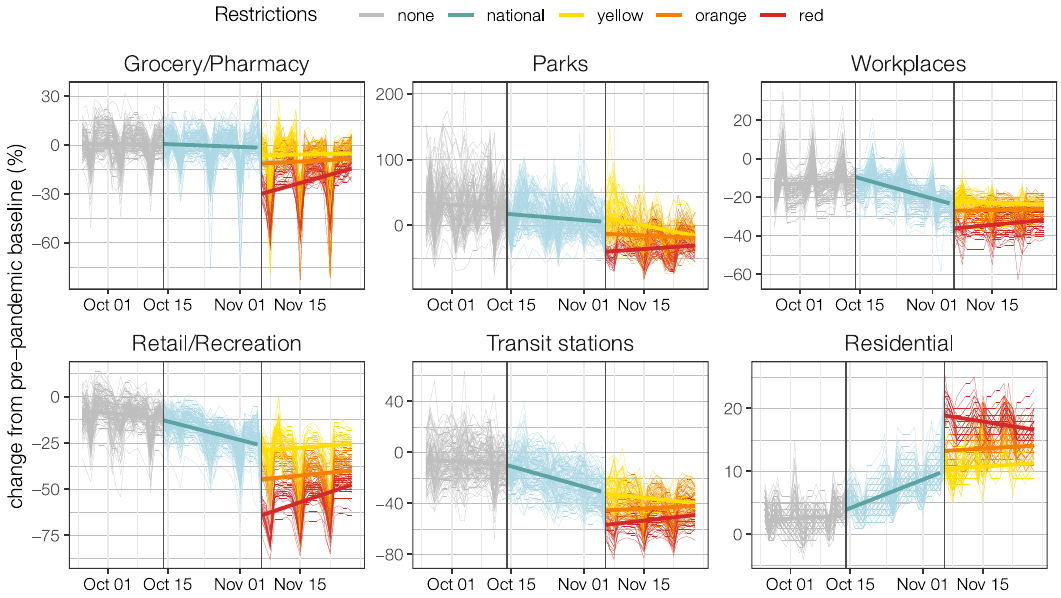
Fig. 1 Changes in the time spent in different locations relative to pre-pandemic values over time 8 , September 25 – November 25. Colors represent three distinct intervention periods, separated by vertical darker lines: September 25 – October 13 (gray, no interventions), October 14 – November 5 (teal, national interventions), November 6 – November 25 (yellow, orange and red, aggregating provinces by the corresponding tier). Thin lines represent values for individual provinces. Thick lines are regression lines computed over provinces with the same restrictions and are reported to help the visual identi fi cation of trends in different periods. Table 2 Change in the number of visitors in different locations relative to pre-pandemic values, as estimated by a linear mixed model (mean and 95%CI, values in